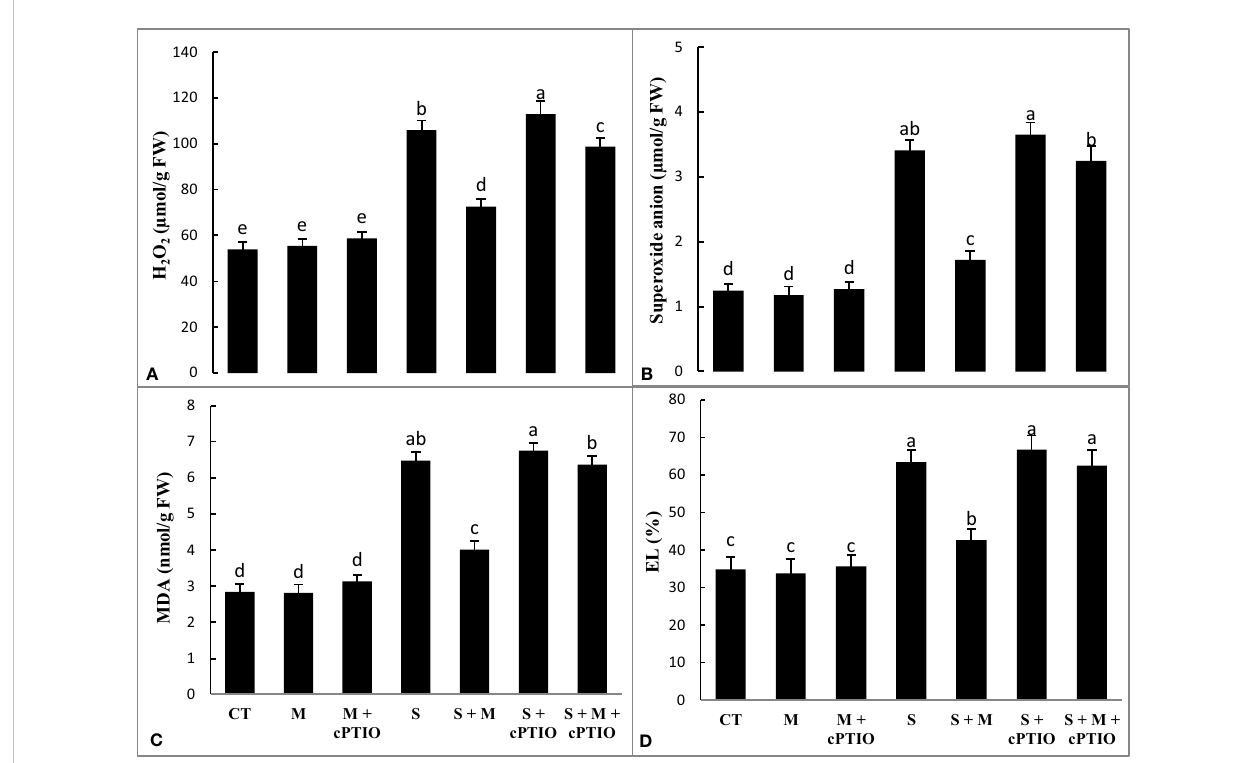
FIGURE 2 The leaf contents of hydrogen peroxide (H 2 O 2 , A ), superoxide anion radical (B) , malondialdehyde (MDA, C ), and electrolyte leakage (EL, D ) in tomato seedlings treated with melatonin (150 m M) and cPTIO (100 m M) under NaCl (150 mM) treatment. Different letters in each column show signi fi cant differences at the p < 0.05 based on the LSD test (means ± SD, n = 5), CT, control treatment; M, melatonin; S,